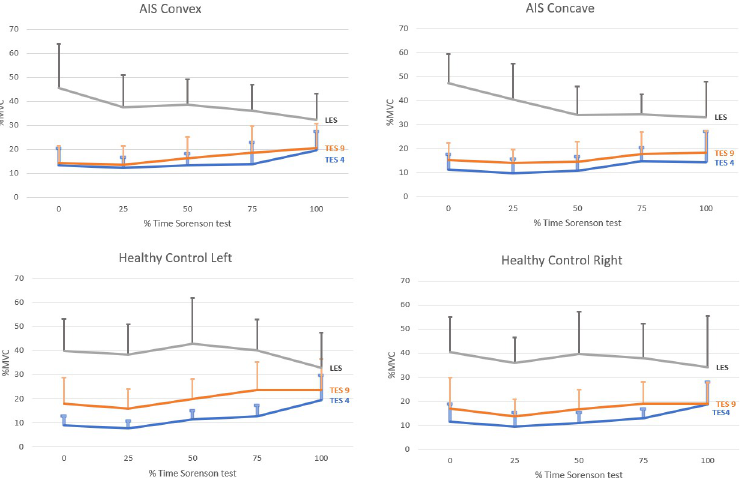
Fig 4. Muscle activation (expressed in percentage of maximal voluntary contraction [%MVC]) of TES4, TES9 and LES during the fatigue task (mean + SD).